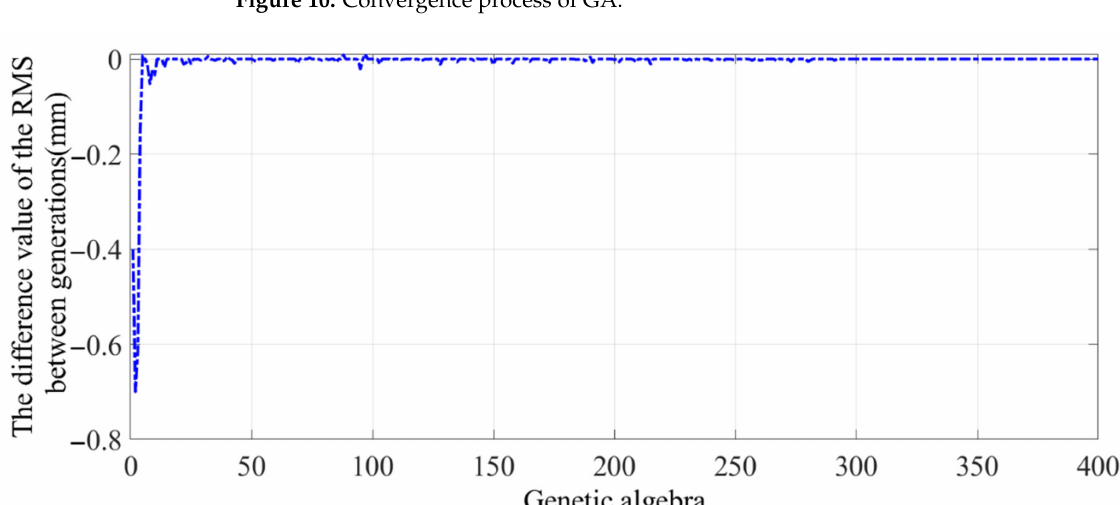
Figure 10. Convergence process of GA.